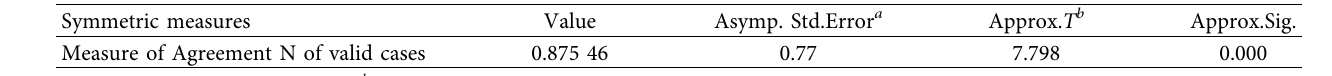
Table 2: Cohen’s kappa